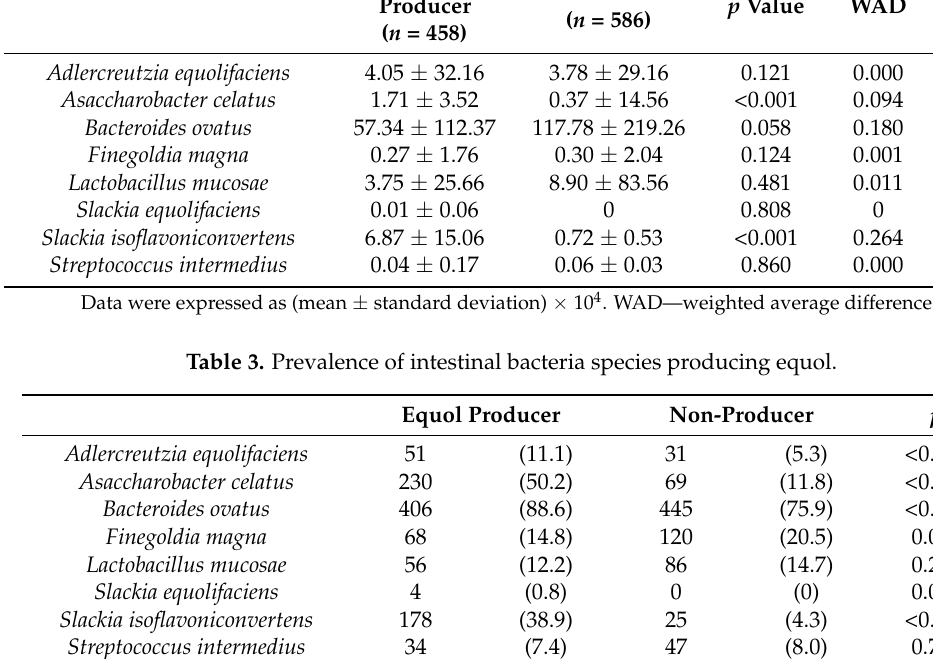
Table 2. Relative abundance of species (percentage of the total bacterial 16sRNA). Equol